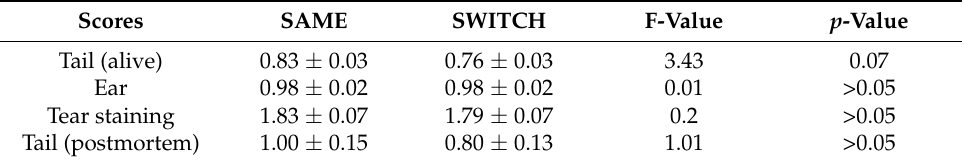
Table 5. The lesion scores and tear stains for the SAME and SWITCH groups: The score data are presented as mean ± S.E. (n = 48 per treatment